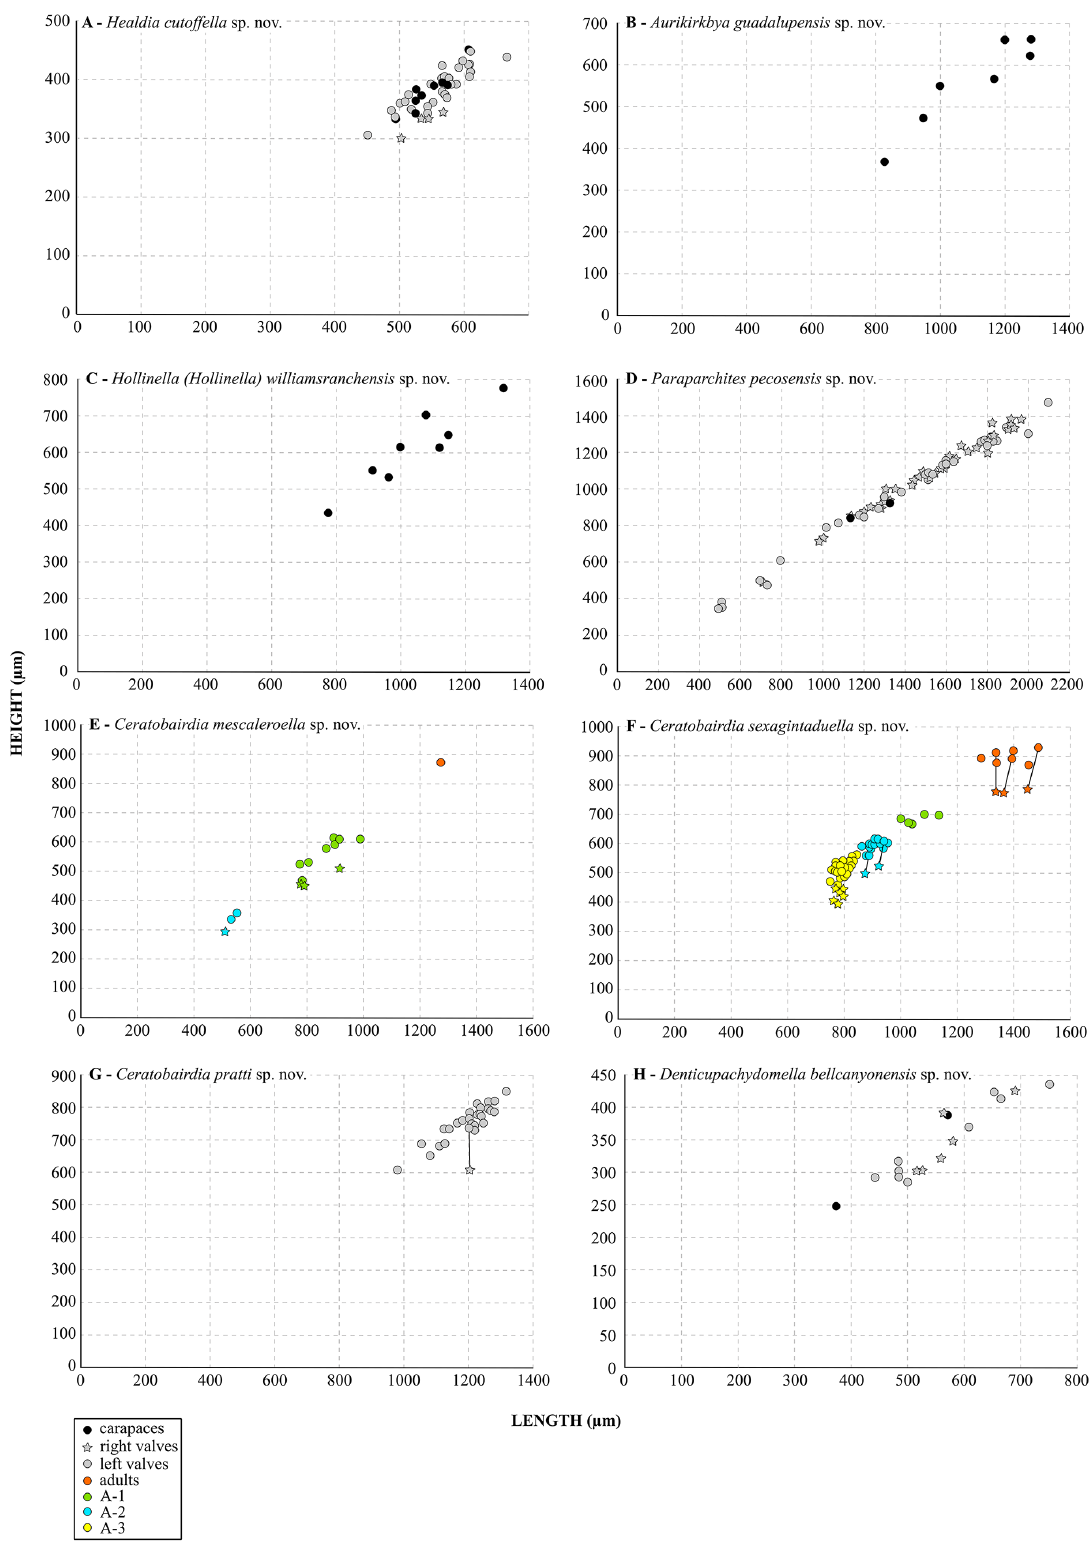
Fig. 5. Height/length scatter plots of species from the Middle Permian (Roadian, Capitanian) of the Guadalupe Mountains (West Texas, USA). A-1, A-2, A-3 . Three last juvenile stages before